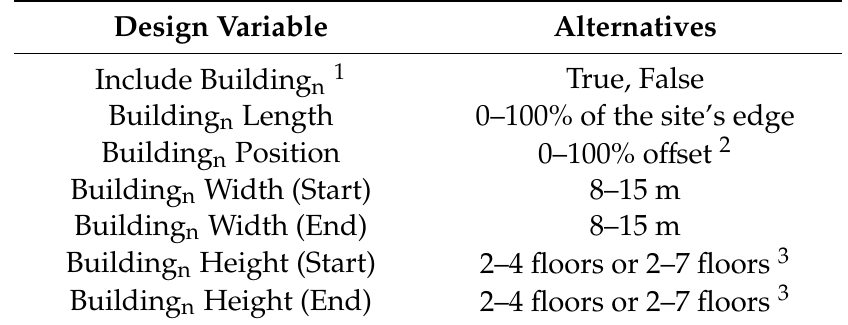
Table 1. List of design variables and their alternatives for each building that were used in the case study of the residential area, where n ∈ [1,2,3,4] corresponds to a specific